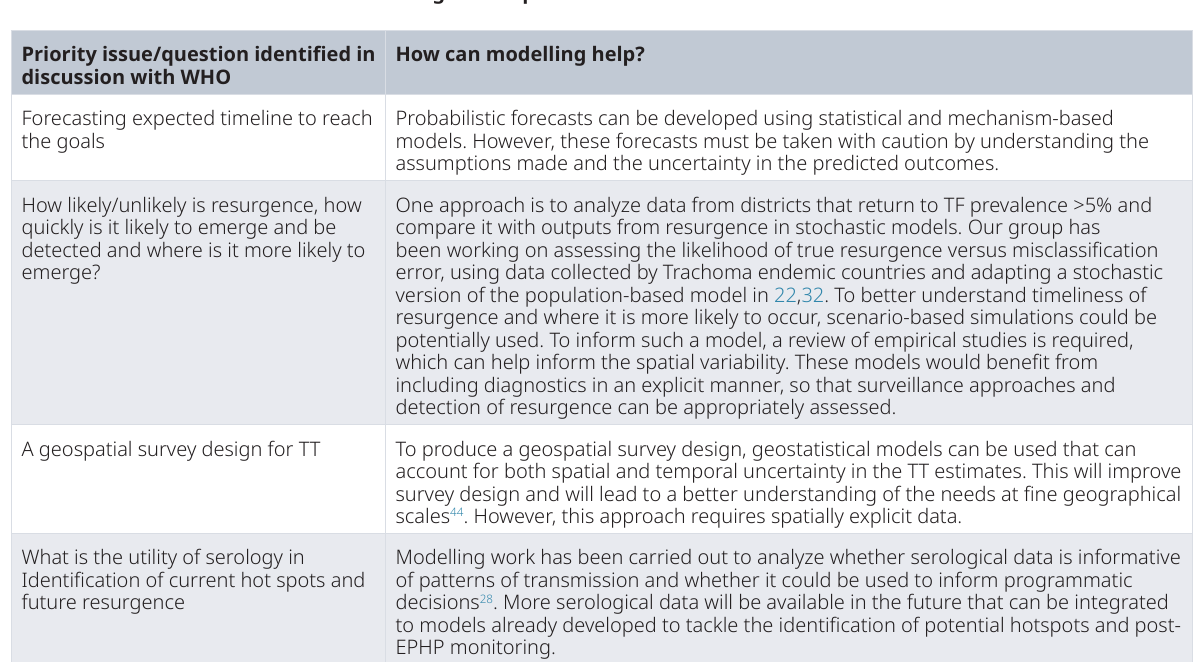
Table 2. Priorities issues and how modelling can help to address